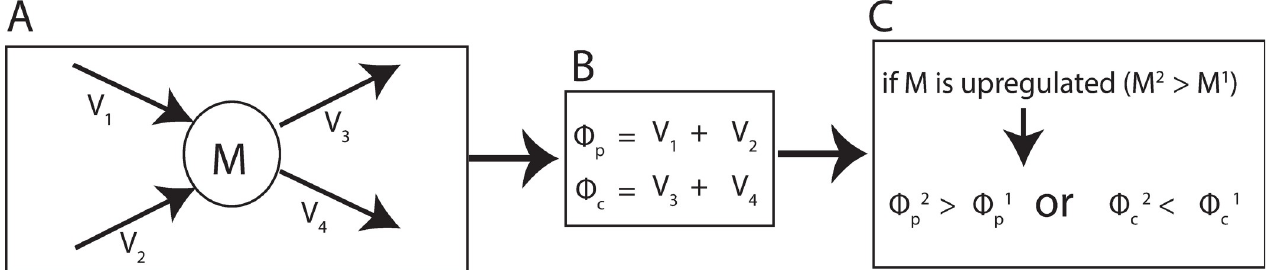
Fig 4. The relative metabolite integration within REMI. (A) an example of a metabolite (M) that is produced by two reactions (v1 and v2) and consumed by two reactions (v3 and v4). (B) sum of production and sum of consumption are denoted ϕ p by and ϕ c respectively.(C) the possible scenarios of ϕ p and ϕ c comparison when the metabolite (M) is